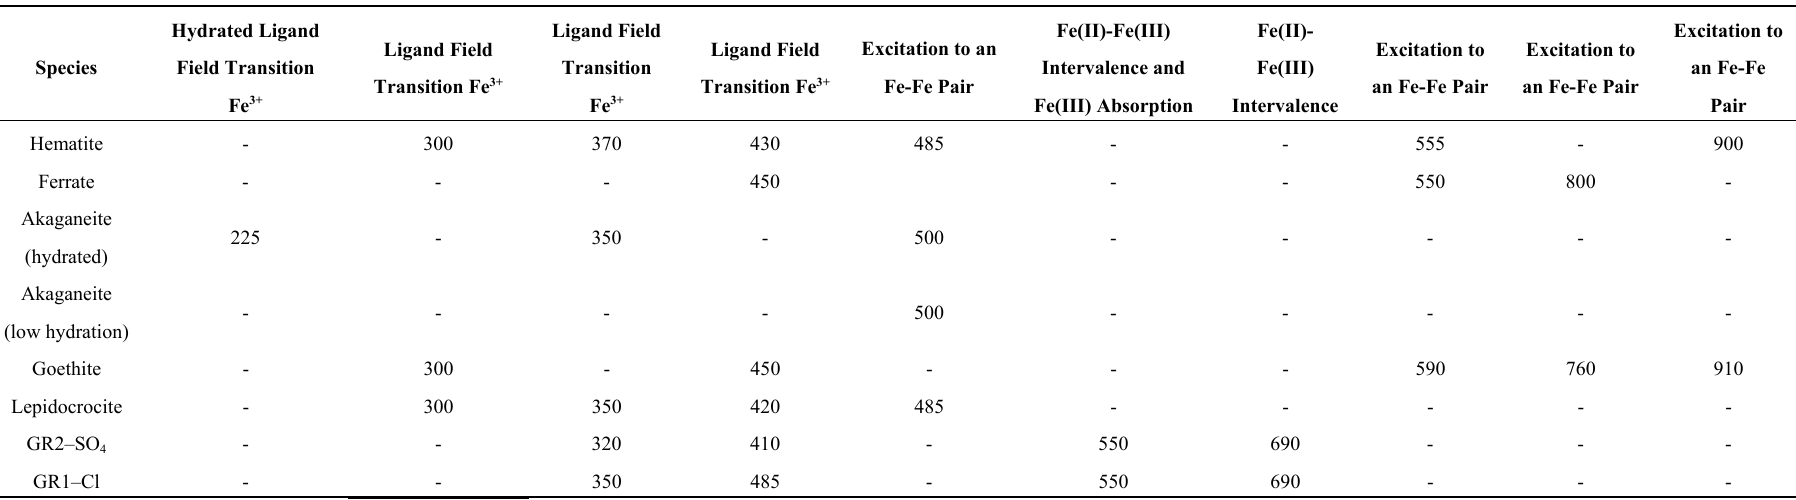
Table 3. UV-Visible Spectral Bands Associated with GR1, GR2 and associated iron corrosion species. Data: [90,92,101–107].